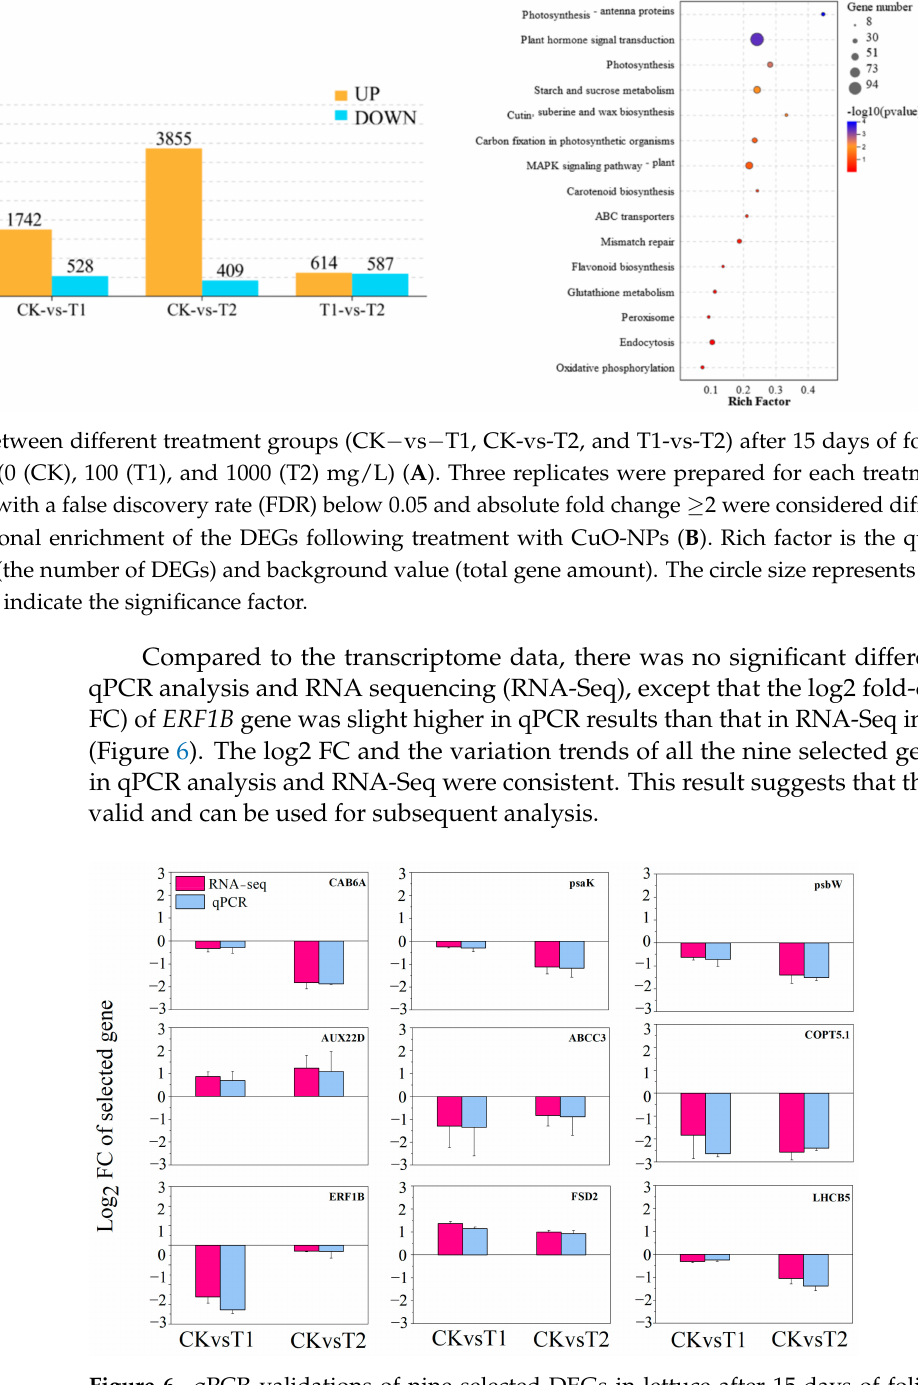
Figure 6. qPCR validations of nine selected DEGs in lettuce after 15 days of foliar exposure to CuO-NPs (0 (CK), 100 (T1), and 1000 (T2) mg/L). The housekeeping gene actin (ACT7) was chosen as the internal reference gene. Values are expressed as the mean of three replicates ( ± SD) for each